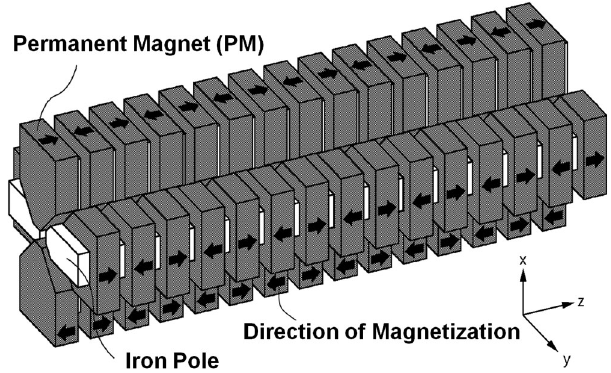
FIG. 1. Magnetic design of the V-P helical permanent-magnet undulator. The undulator is a combination of two planar hybrid permanent-magnet